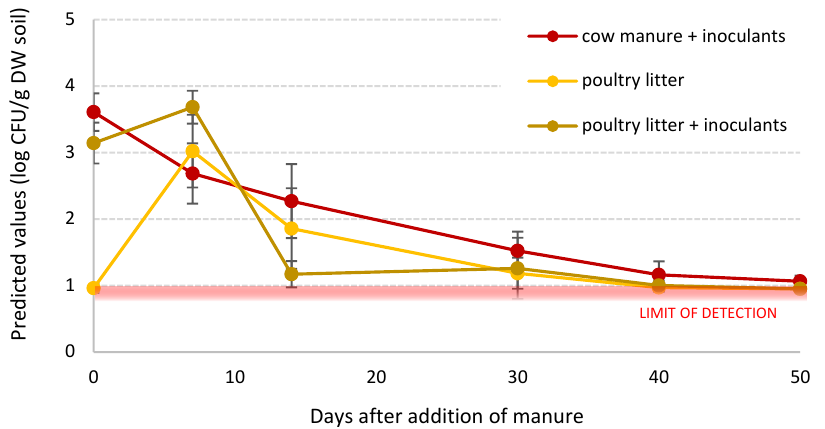
Figure 4. Predicted populations of E. coli in soil following amendment with cow manure inoculated with E. coli + L. innocua ; poultry litter alone; or poultry litter inoculated with E. coli and S. sofia. Bars indicate the confidence interval of each predicted value. Note that there were no detections of E. coli in cow manure only.